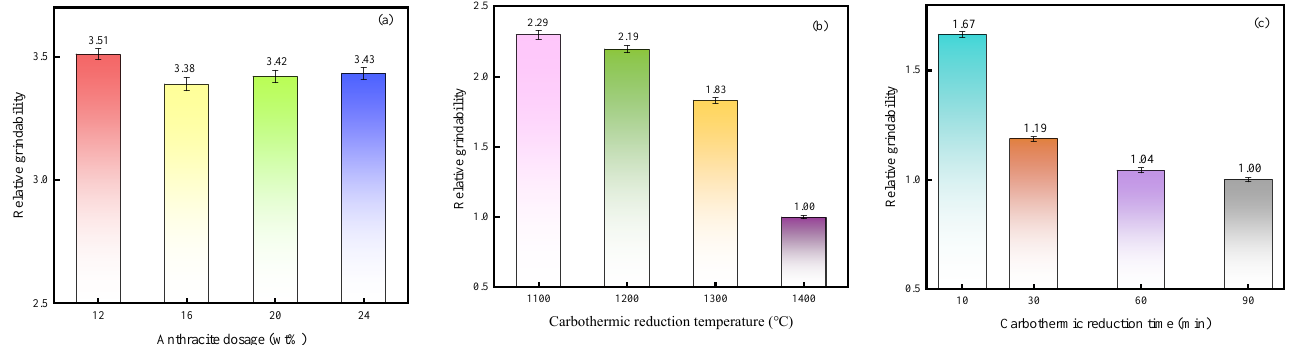
Figure 7. Relative grindability at various ( a ) anthracite dosage, ( b ) carbothermic reduction temperature, and ( c ) carbothermic reduction time.